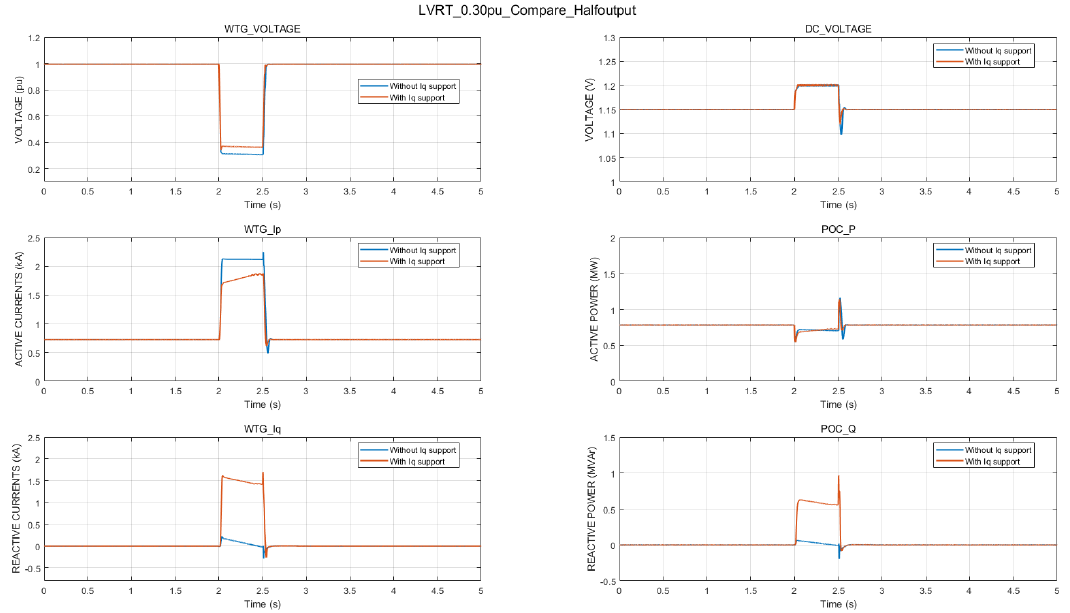
Figure 11. Comparison study of a 0.30 pu LVRT incident with half active power output.